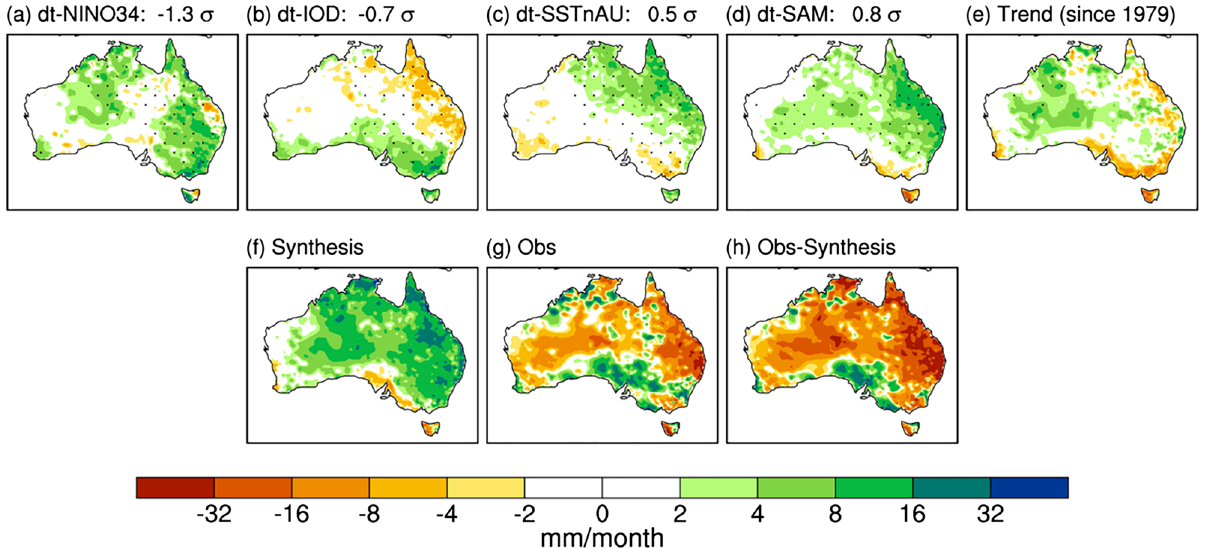
Figure 3. Synthesis of 2020 spring rainfall anomalies using multiple linear regression onto key climate indices. The contributions from the individual predictors are ( a ) de-trended Niño3.4 SST index, ( b ) de-trended DMI, ( c ) de-trended SSTs north of Australia (eq-10°S,110–160°E), ( d ) de-trended SAM, and ( e ) time (i.e., trend). The full synthesis using all five predictors is shown in ( f ). ( g ) Observed 2020 spring rainfall anomaly relative to the climatology of 1990–2012. ( h ) Difference between the observed and the synthesized rainfall. The BoM official base period is 1961–1990, and the anomaly pattern relative to this earlier base period is similar to ( g ) (http:// www. bom. gov. au/ clima te/ maps/ rainf all/? varia ble= rainf all& map= anoma ly& period= 3mont h& region= nat& year= 2020& month= 11& day= 30). In ( a )–( e ) synthesis anomalies were computed by the regression coefficients obtained over 1979–2019 and then scaled by the predictor values of 2020 (see “Methods”). Stippling in ( a )–( e ) indicates where correlation between the rainfall and each predictor is statistically significant over 1979–2019 at the 5% level. Maps were generated using the NCAR Command Language version 6.6.2 (www. ncl. ucar.